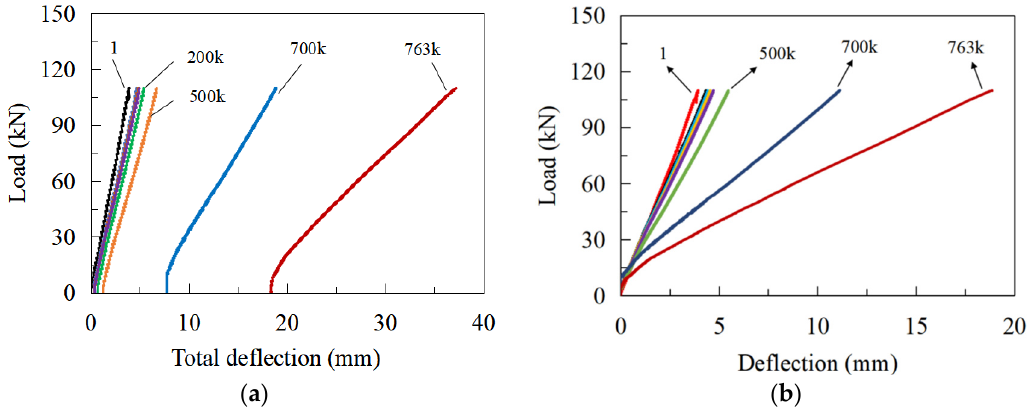
Figure 11. Load-deflection curves under P max : ( a ) with residual deflection; ( b ) without residual deflec- tion.